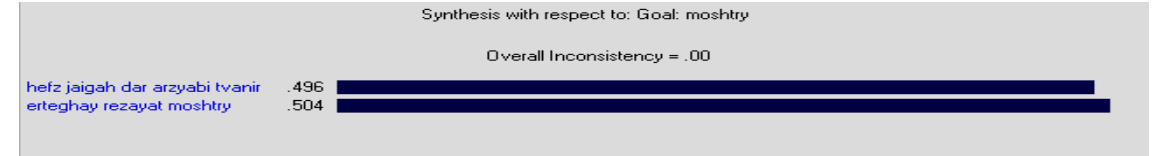
Figure3. Results of the final combination of customer's perspective strategies